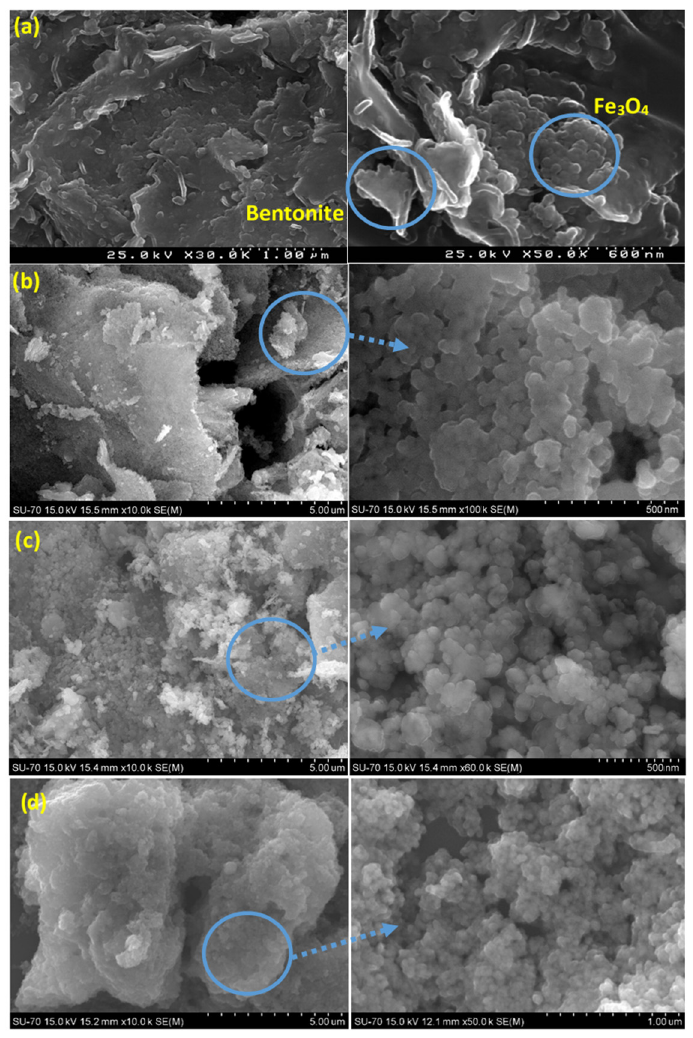
Figure 2. SEM images of Fe 3 O 4 /Bentonite ( a ), ZnO ( b ), ZnO/Bentonite ( c ), and ZnO/ γ -Fe 2 O 3 /Bentonite ( d ).